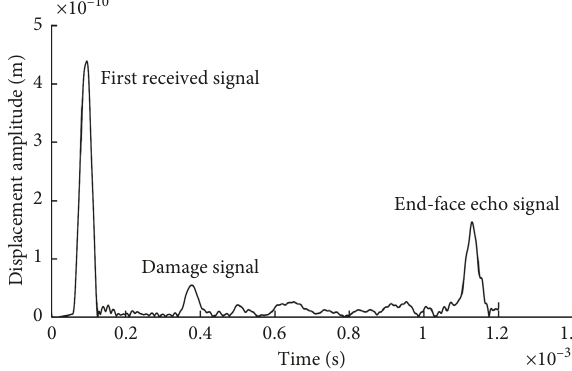
Figure 19: Guided time domain diagram of the Hilbert transform.